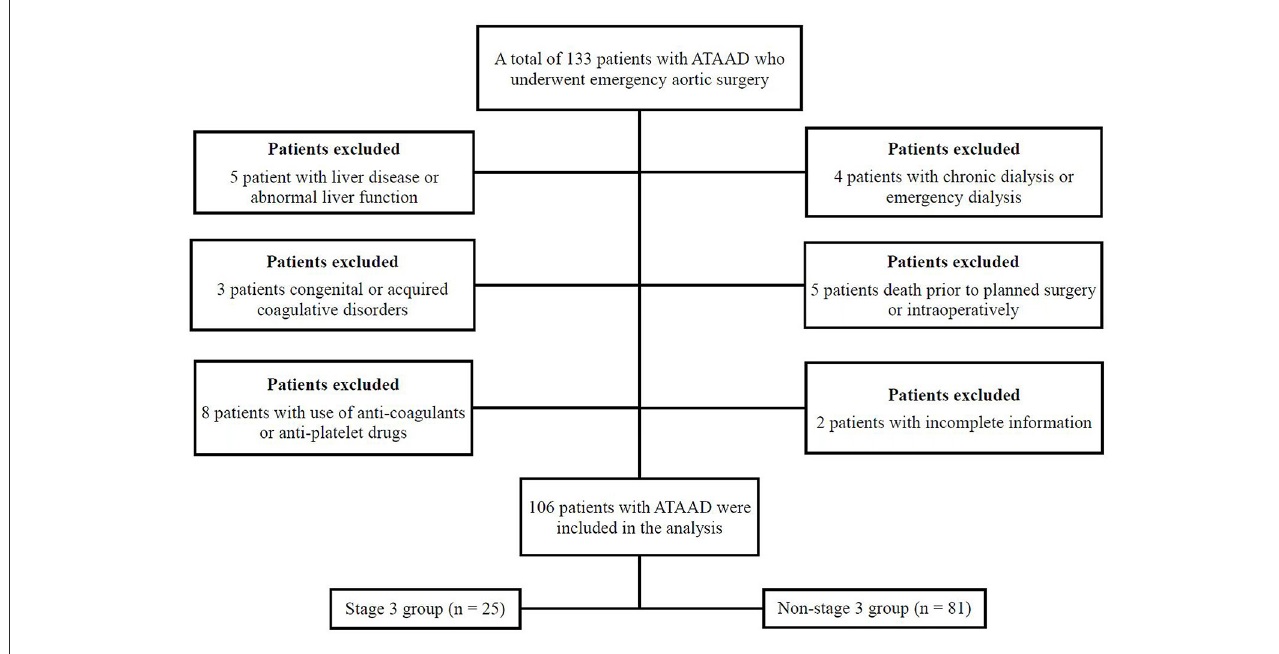
FIGURE1 A flowchart of the study cohort.